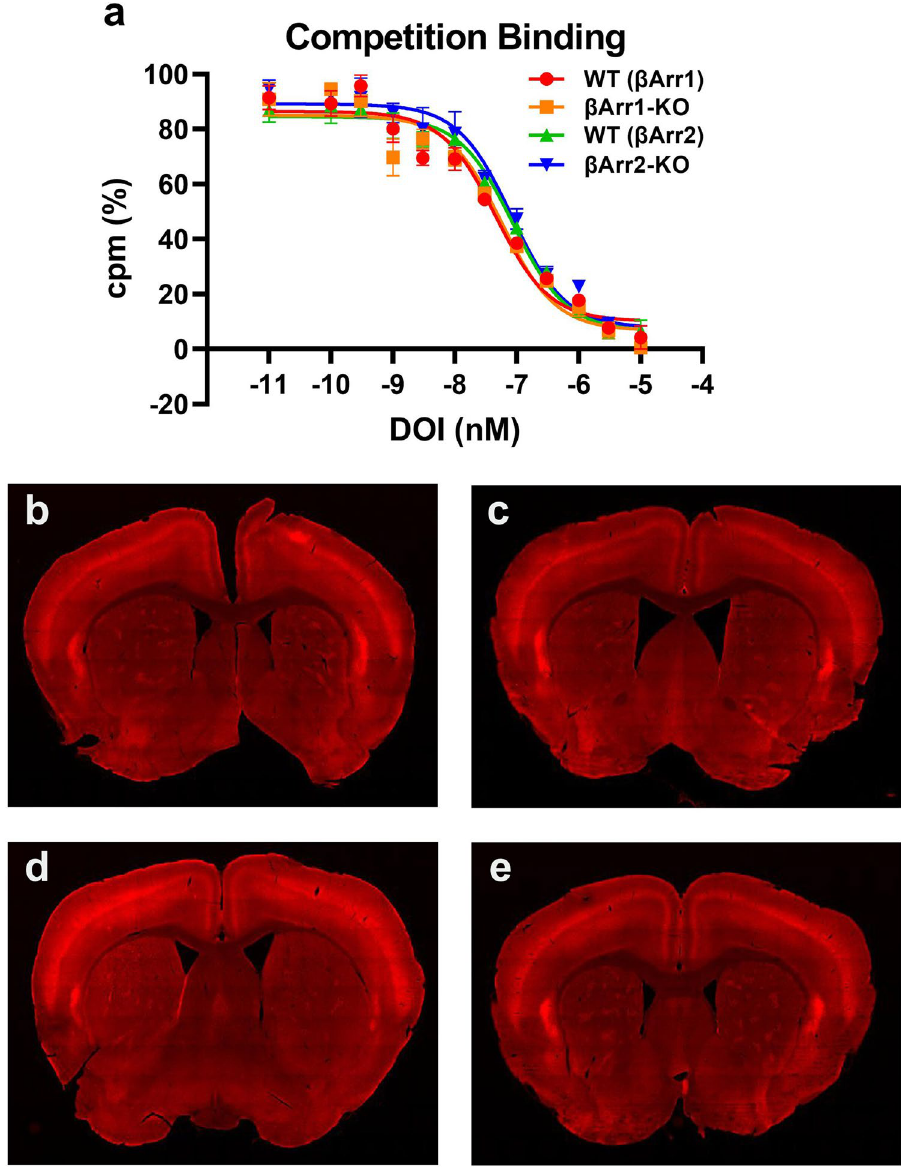
Figure 7. Radioligand binding and immunohistochemistry of 5-HT2ARs in βArr1 and βArr2 mice. ( a ) Competition binding with [ 3 H]-ketanserin using membranes from βArr1 and βArr2 brains. The K d values for binding were 21.3, 26.8, 40.8, and 38.7 nM from WT and βArr1-KO, and WT and βArr2-KO mice, respectively. N = 3 mice/genotype. ( b-e ) Representative 5-HT2AR immunofluorescence in coronal brain sections from respective WT and βArr1-KO mice ( top ), and WT and βArr2-KO ( bottom )